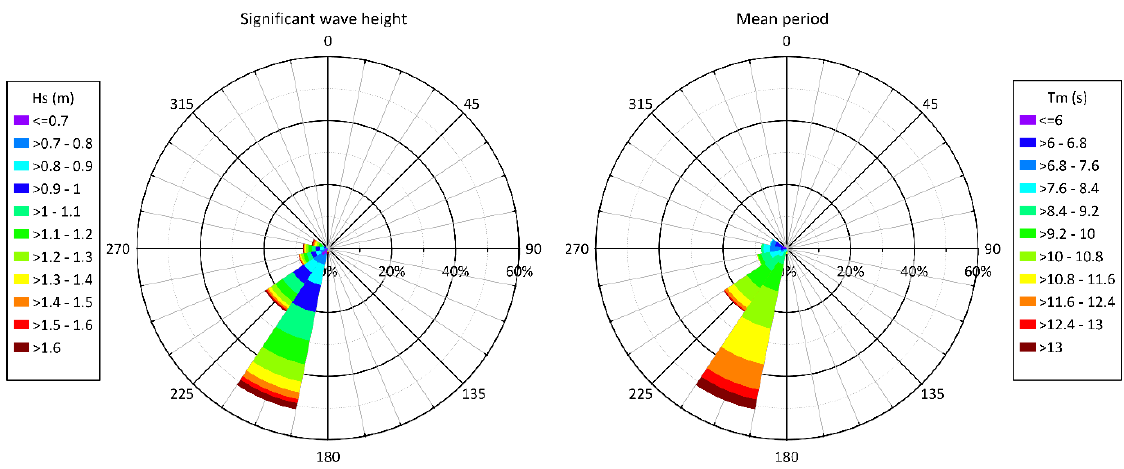
Figure 3. Significant wave height and mean period annual rose diagrams for Mazatlan (1979–2020). The tidal regime at Mazatlan is microtidal, with a range of 0.44 m at neap tide and 0.55 m at spring tide. These values and the tide levels shown in Table 1 were taken from the Mexican Servicio Mareográfico Nacional [32]. Table 1. Tide levels at Mazatlan [32].